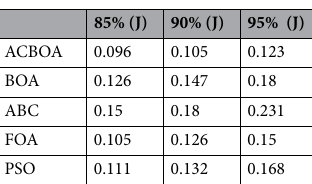
Table 4. Average energy consumed by all nodes working for one